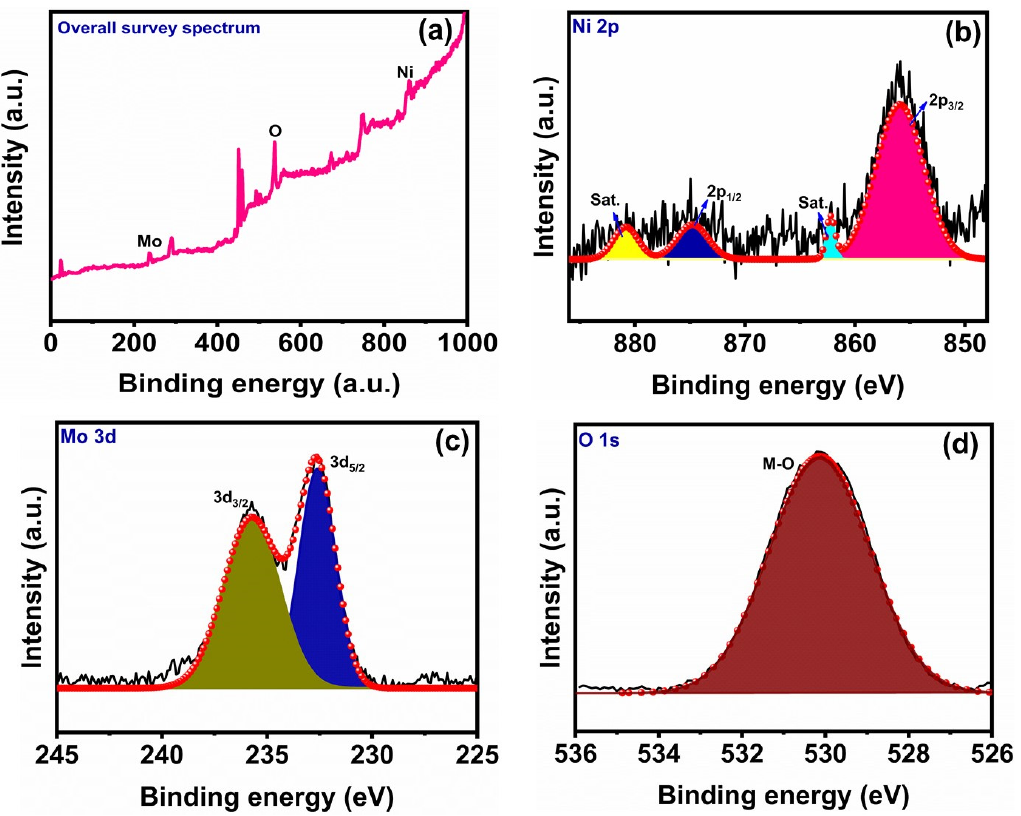
Figure 2. ( a ) XPS overall spectra of NMO and relatively high-resolution XPS spectra of ( b ) Ni, ( c ) Mo, and ( d ) O.